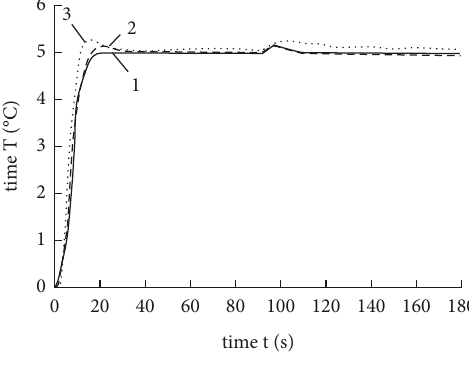
Figure 3: System response